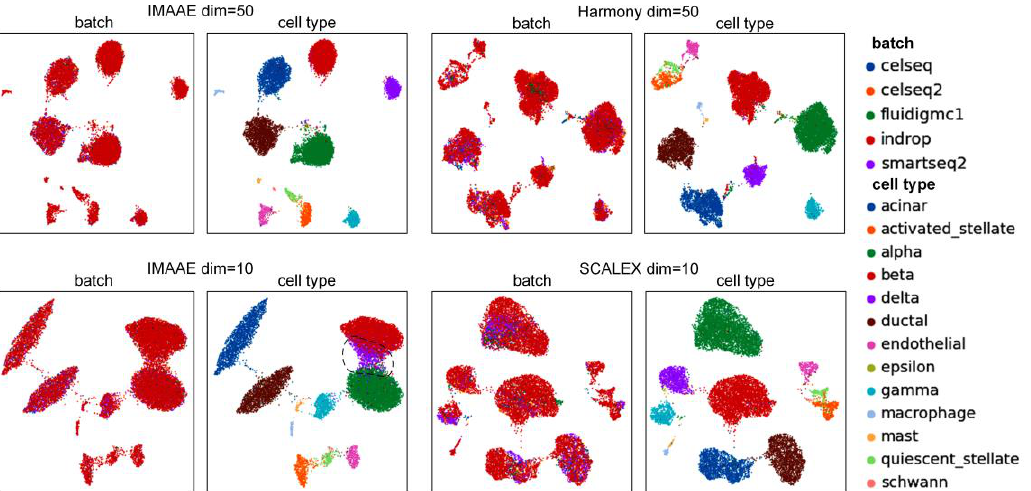
Figure 8. UMAP visualization plots of IMAAE, Harmony, and SCALEX corrected low-dimensional data on the Pancreas dataset.